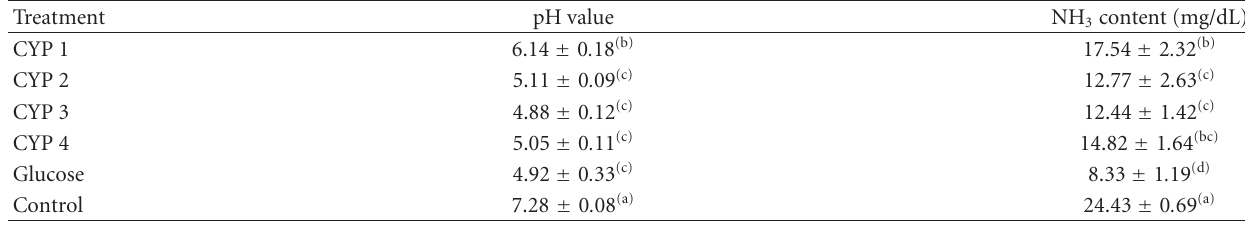
Table 4: pH values and N H 3 contents in the fermentation broth ( n = 4).